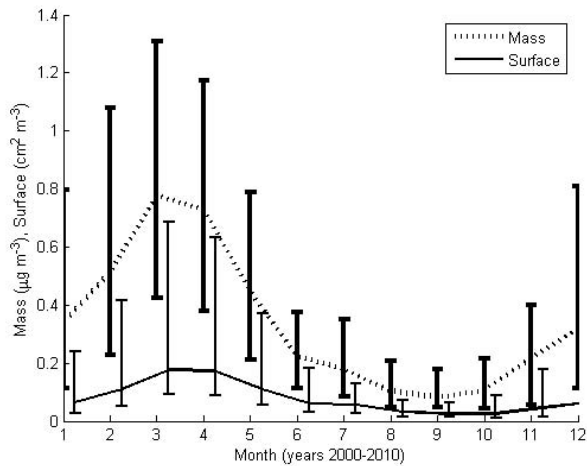
Fig. 8. Annual average variation of integrated surface and mass, March 2000–March 2010. Mass data calculated from aerosol num- ber size distribution assuming a density of ρ = 1gcm − 3 . 25–75th percentile ranges indicated by